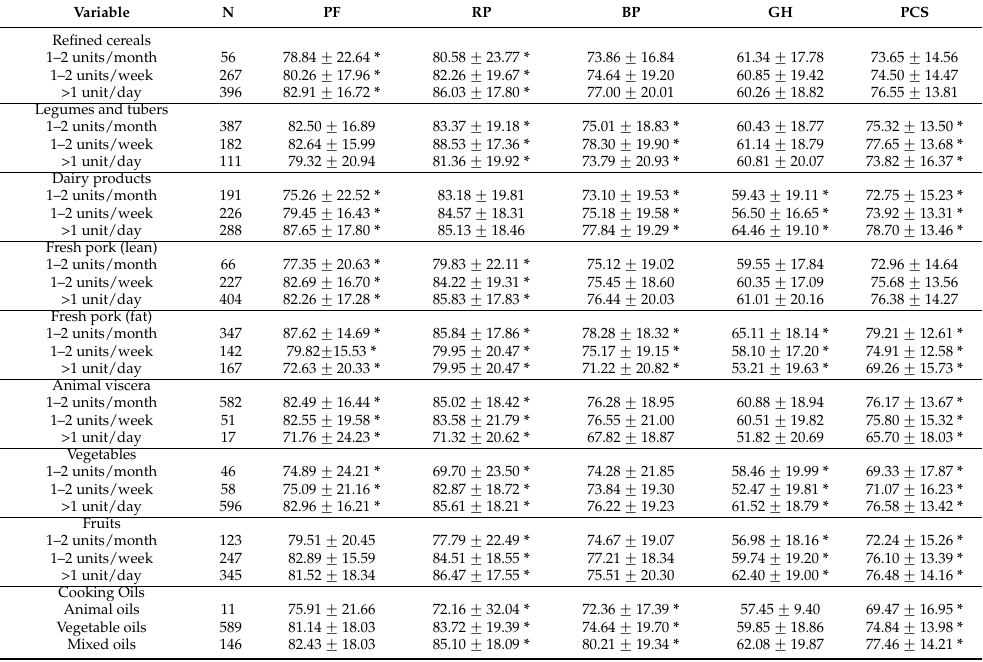
Table 2. Scores of PF, RP, BP, GH and PCS based on dietary factors of scientific workers (Mean ˘